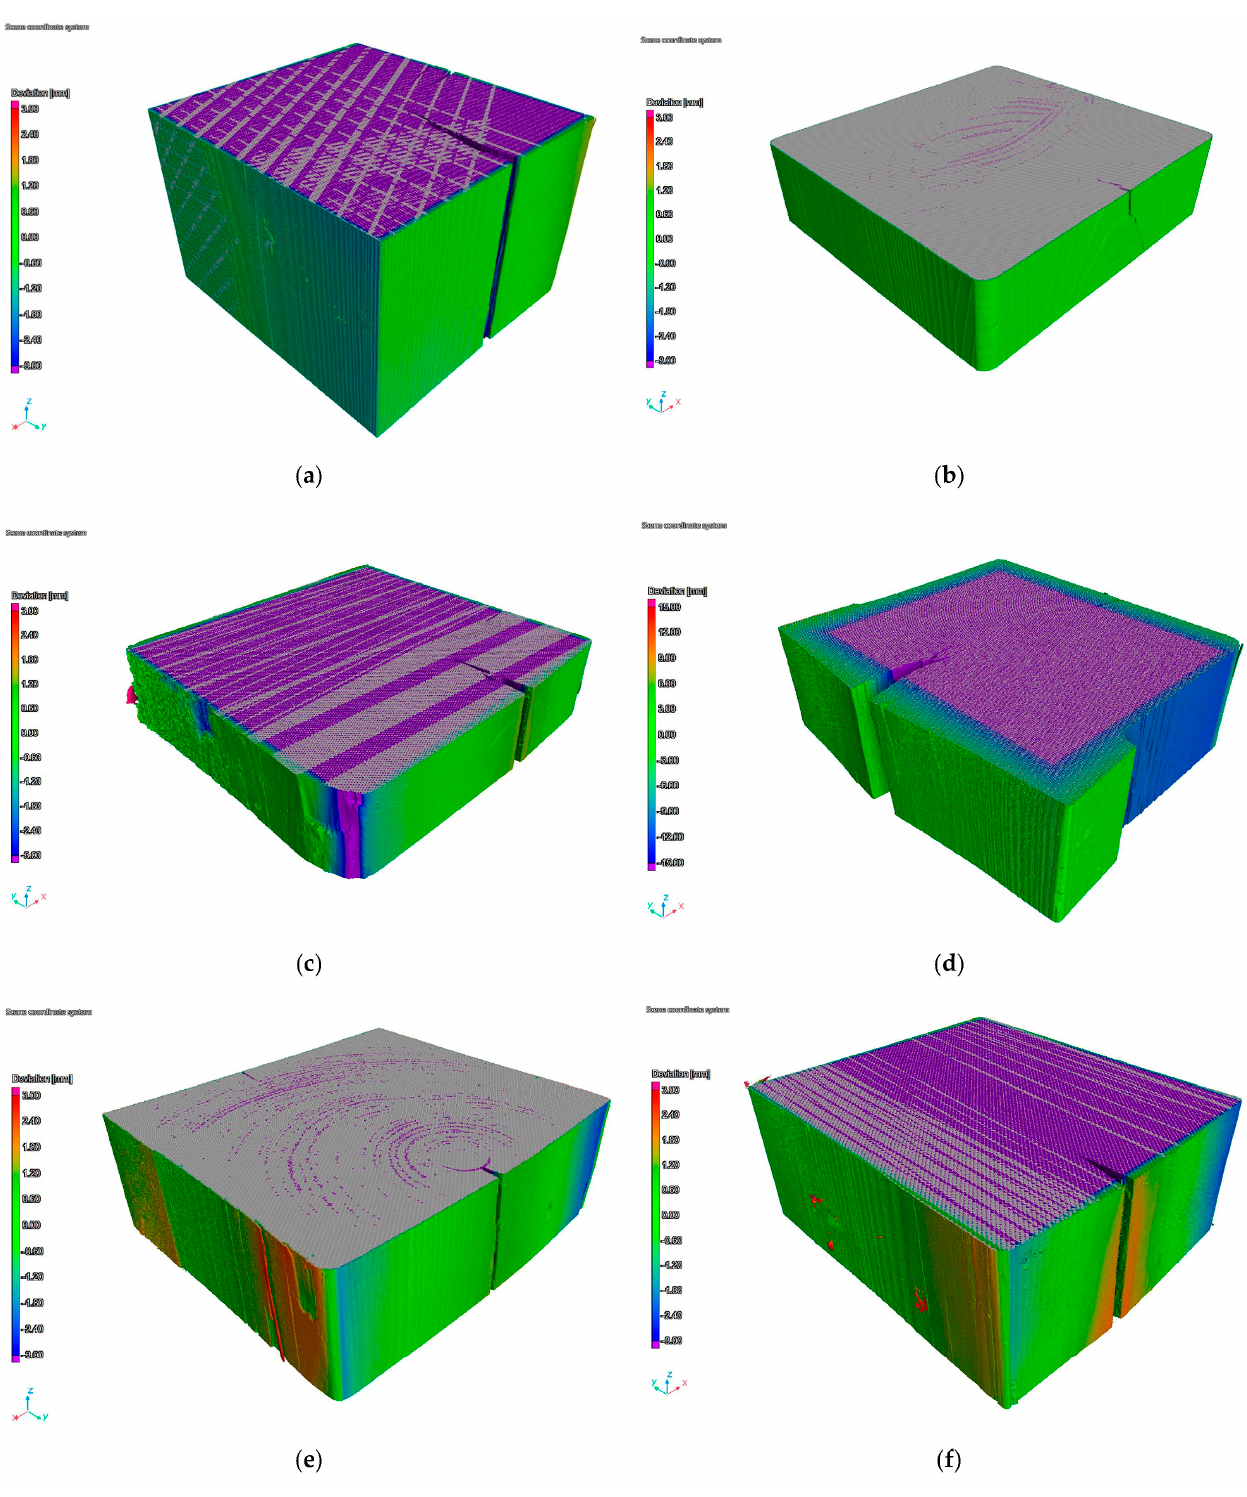
Figure 5. Images of changes in the shape of samples according to CT; ( a ) sample one; ( b ); sample two; ( c ) sample three; ( d ) sample four (larger scale); ( e ) sample five; ( f ) sample six. An analysis comprising bar charts showing shape variations was conducted for se- lected samples’ cross-sections. Positive values (bars inside a cross-section) are sections of the sample where the area of the measured surface is greater than surface of the CAD model, while negative values (bars outside a cross-section) are sections where the real